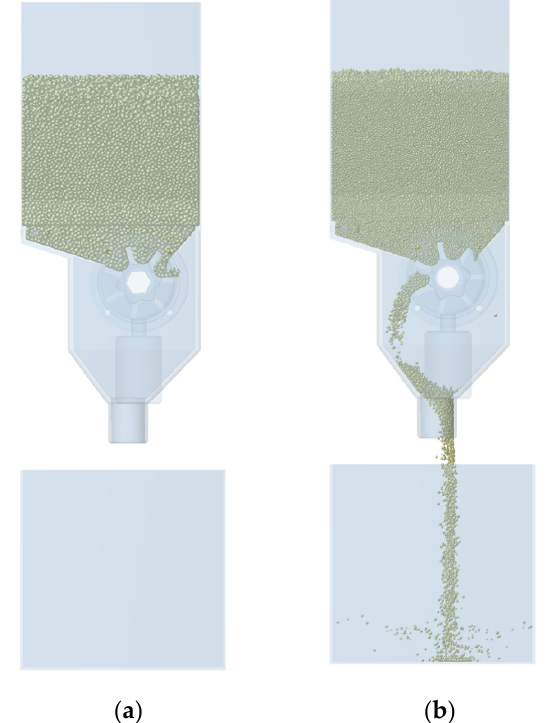
Figure 12. Fertilizer drainage simulation process: ( a ) filling process; ( b ) fertilization process.